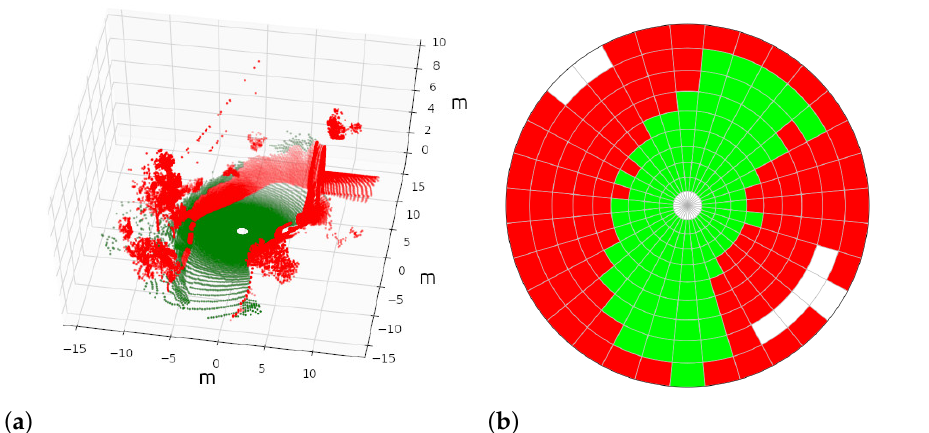
Figure 3. A synthetic 3D point cloud ( a ) and its tagged 2D polar grid ( b ) for training the RF cell